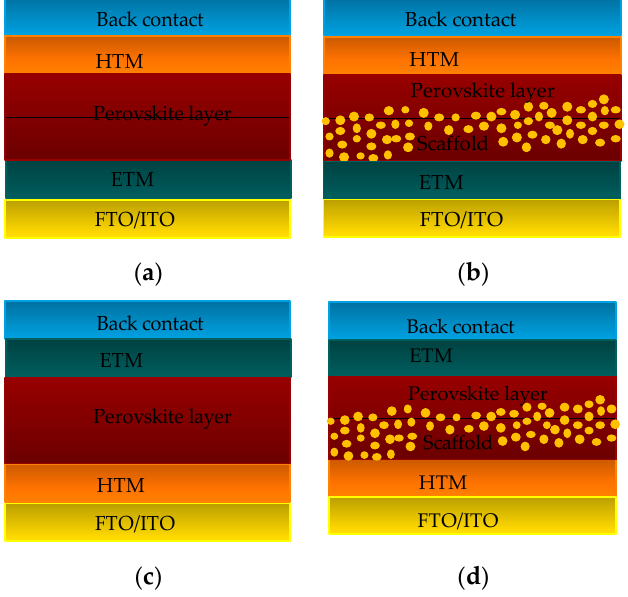
Figure 1. Perovskite solar cell (PSC) device architectures: ( a ) planar n-i-p device; ( b ) mesoscopic n-i-p device; ( c ) planar p-i-n device; and ( d ) mesoscopic p-i-n device.